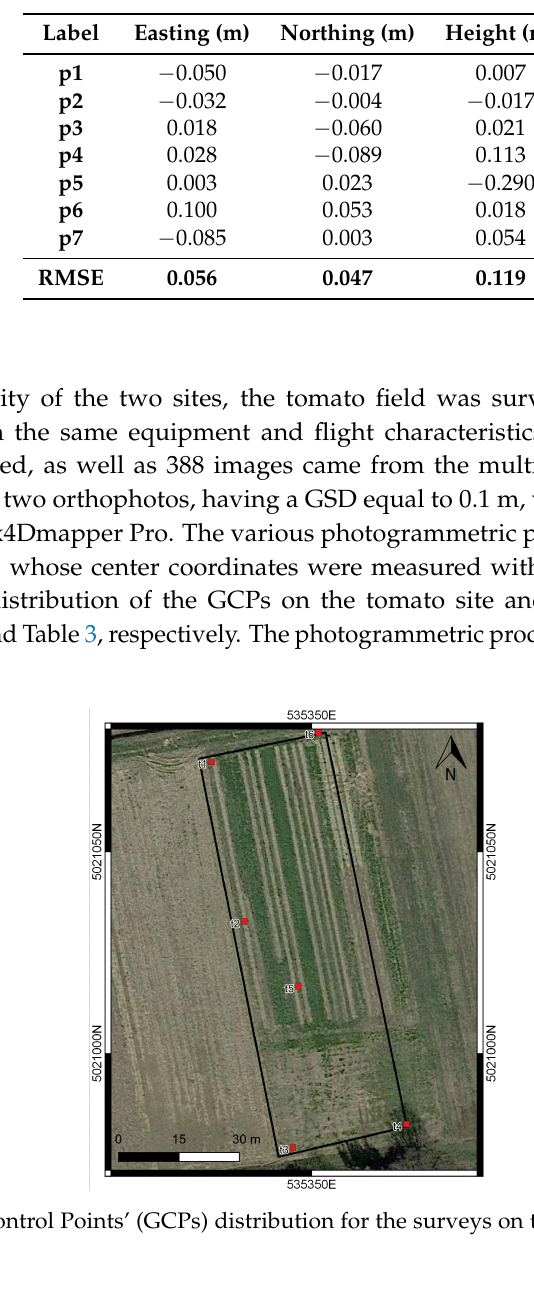
Table 2. Pear orchard site: residuals on the GCPs after bundle block adjustment.